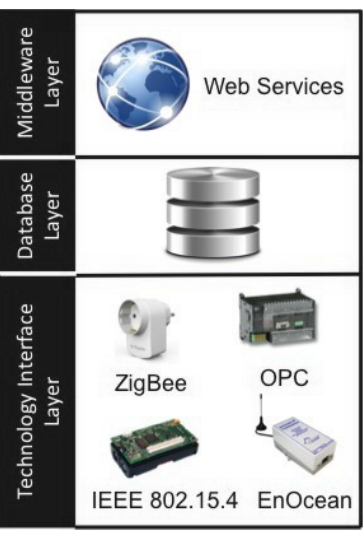
Figure 3. Device-Proxy